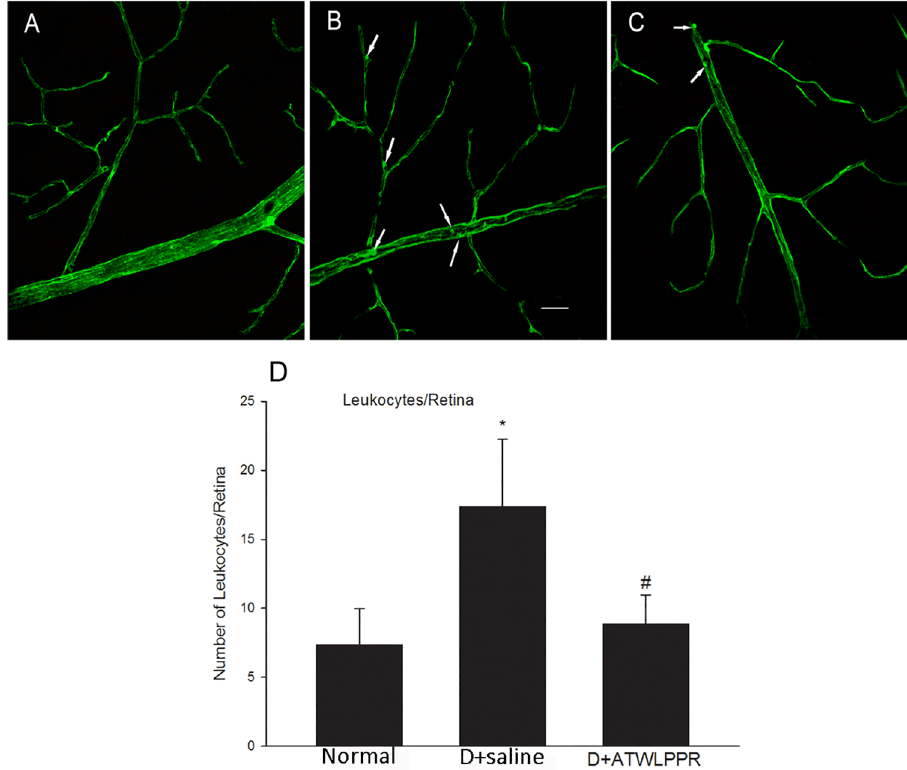
Fig 4. Treatment with ATWLPPR reduced the leukocyte attachment. Con A perfusion retinas show attached leukocytes (arrows) within the vasculature of diabetic retinas. Representative retina flat-mount images from (A) Normal, (B) D+saline and (C) D+ATWLPPR groups. (D) Quantitative analysis of leukocyte adhesion. Scale bar = 40 mm. * P < 0.05, versus the Normal group; # P < 0.05, versus the D+saline group. D,